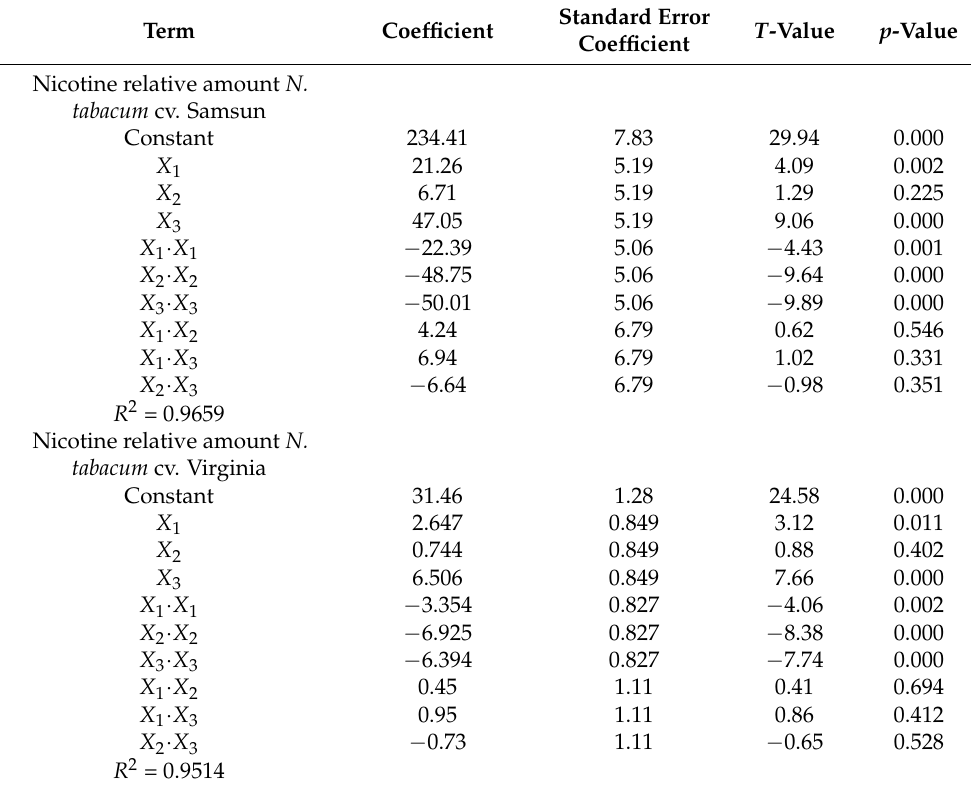
Table 7. The response surface regression coefficients of the polynomial function for the N. tabacum cv. Samsun and N. tabacum cv. Virginia leaves’ nicotine relative amount (mg nicotine equivalents per 100 g of plant material).